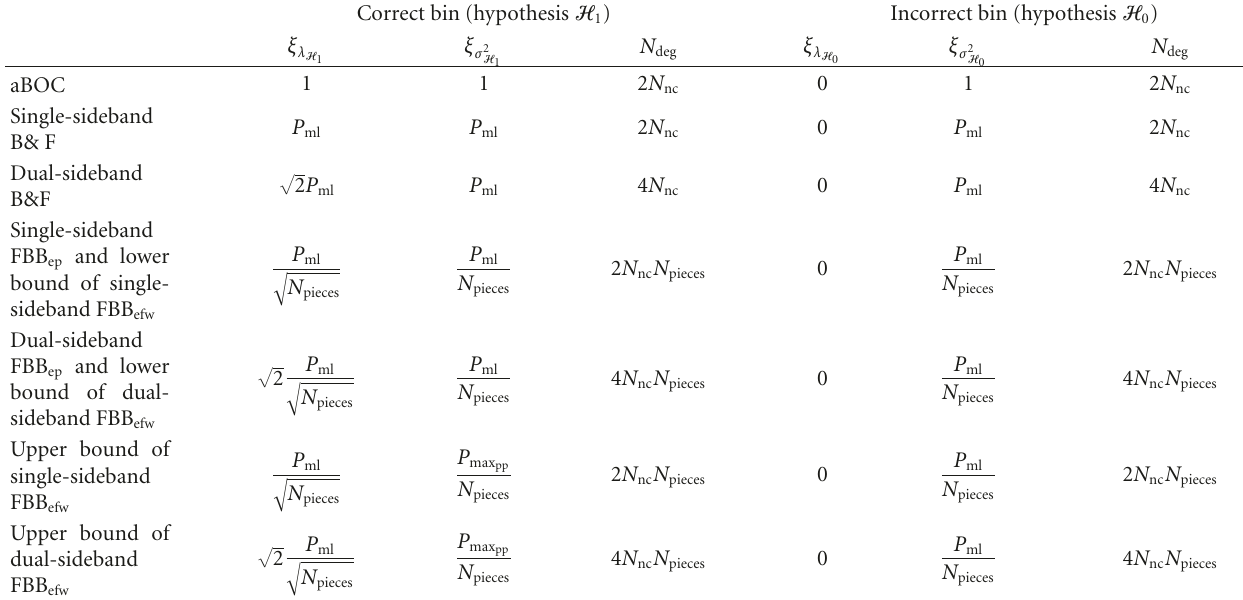
Table 1: χ 2 parameters for the distribution of the decision variable Z , various acquisition methods.